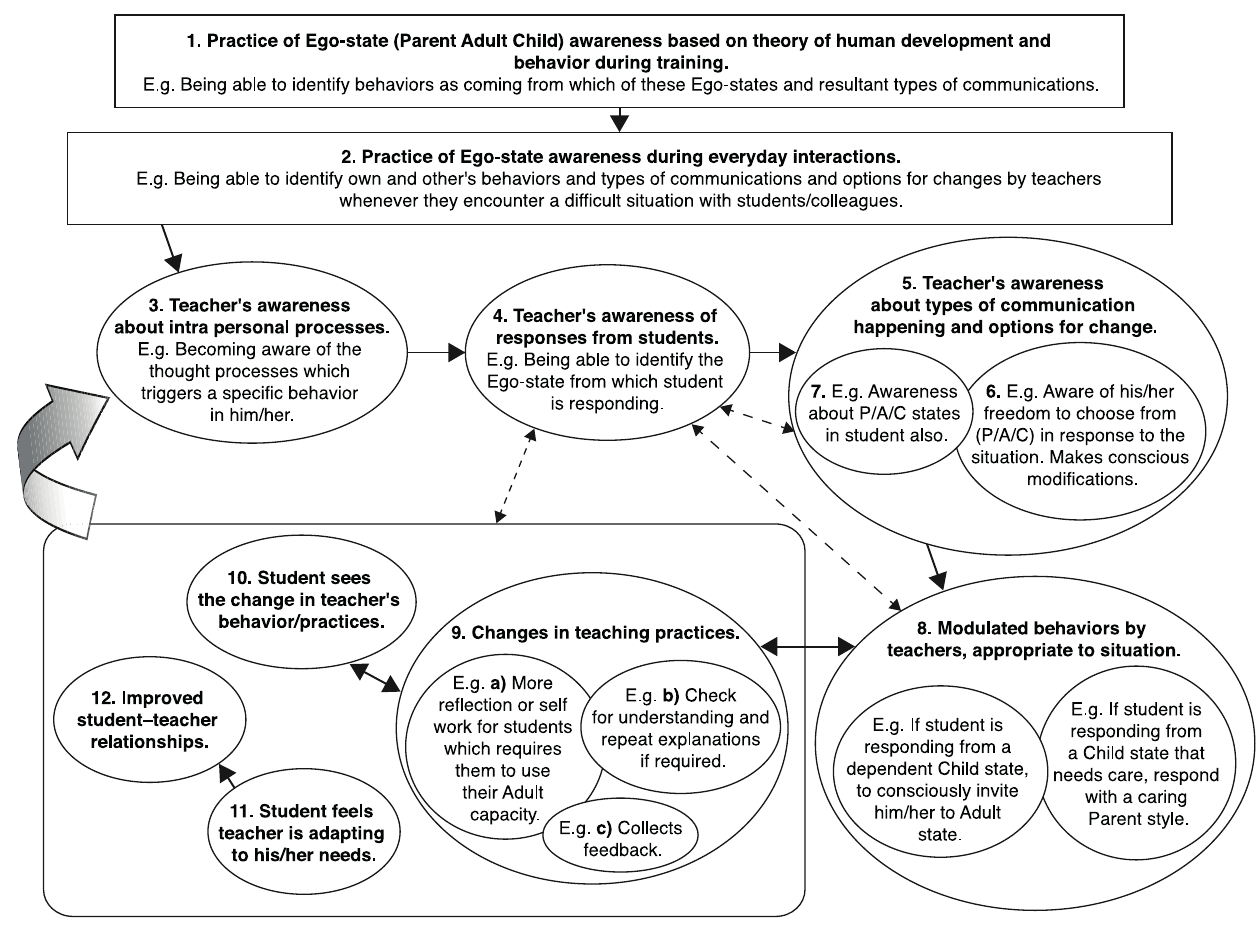
Figure 1. Dynamics of self-awareness and self-directed behavior